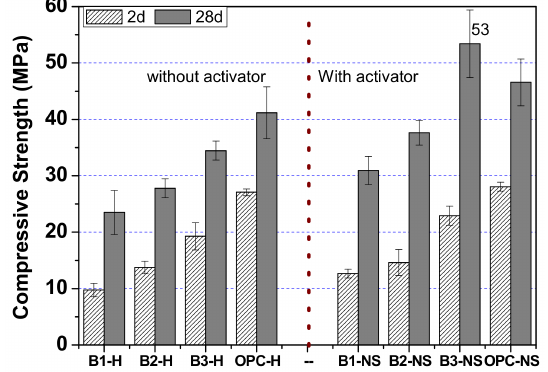
Figure 6. The 2 days and 28 days compressive strength (MPa): B1, (80% BT/20% OPC; B2, 70% BT/30% OPC; and B3, 60% BT/40%